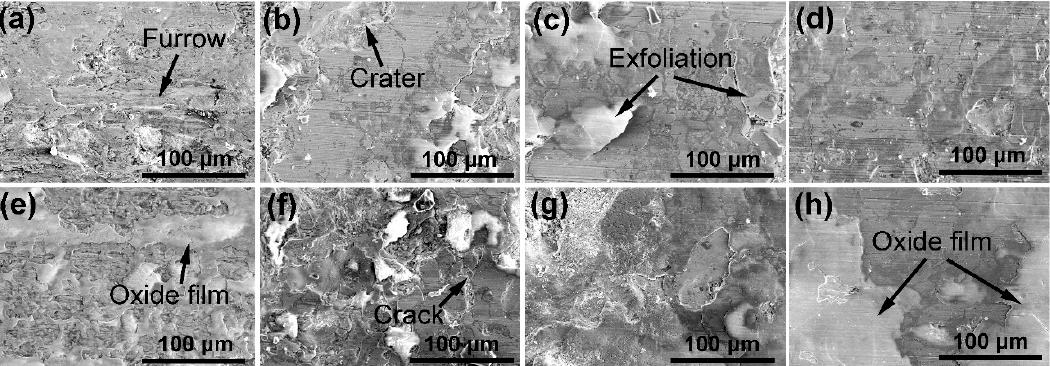
Figure 6. Worn surface of the coatings with various sliding speeds: ( a ) the substrate at 5 mm · s − 1 ; ( b ) the Fe 65 P 5 Si 9 B 10 coating at 5 mm · s − 1 ; ( c ) the Fe 65 P 5 Si 9 B 10 Cr 10 coating at 5 mm · s − 1 ; ( d ) the Fe 65 P 5 Si 9 B 10 Cr 10 Nb 1 coating at 5 mm · s − 1 ; ( e ) the substrate at 45 mm · s − 1 ; ( f ) the Fe 65 P 5 Si 9 B 10 coating at 45 mm · s − 1 ; ( g ) the Fe 65 P 5 Si 9 B 10 Cr 10 coating at 45 mm · s − 1 ; and ( h ) the Fe 65 P 5 Si 9 B 10 Cr 10 Nb 1 coating at 45 mm · s − 1